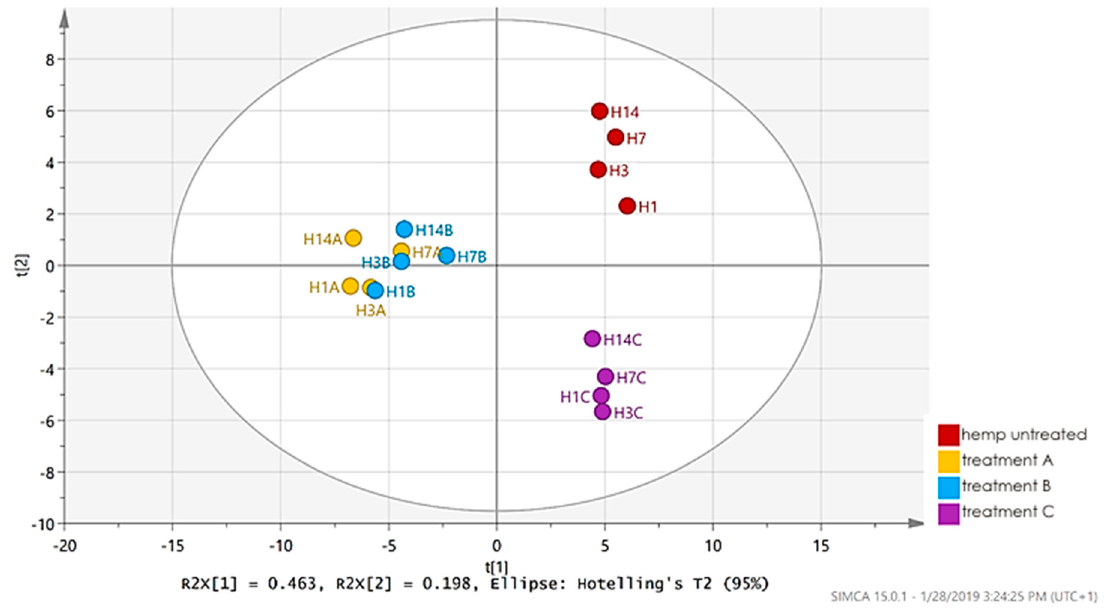
Figure 5. PLS-DA score plot: (H1-14—hemp with no treatment, H1A-14A—hemp shive and tartaric acid; H1B-14B—hemp shive and citric acid; H1C-14C—hemp shive and sodium bicarbonate)